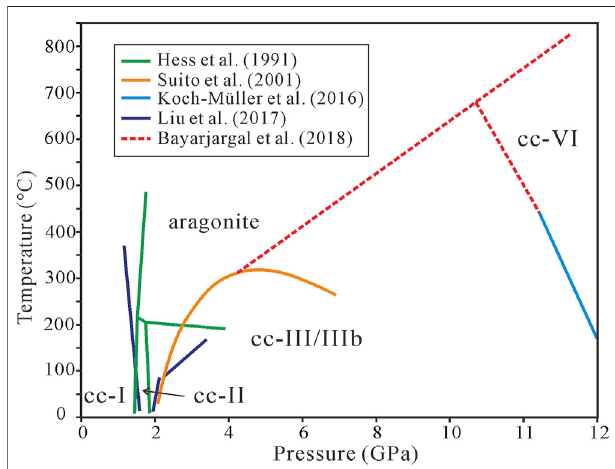
FIGURE 1 | The phase boundaries between calcite and aragonite from previous study. Under lowpressures and temperatures, these boundaries are close, but they exhibit signi fi cant deviations for high pressures and